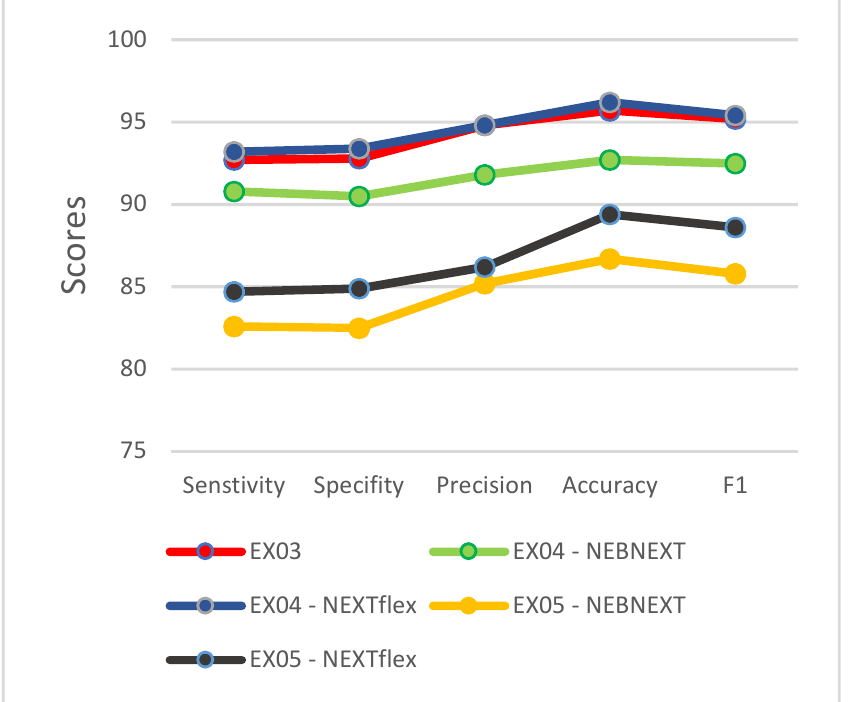
Figure 14. The resulting accuracy scores of EX05, classifying the synthetic samples of Dataset_I into A, B, C, D, and E classes. (a) Samples prepared by NEBNEXT (15 samples); (b) samples prepared by NEXTflex (15 samples).